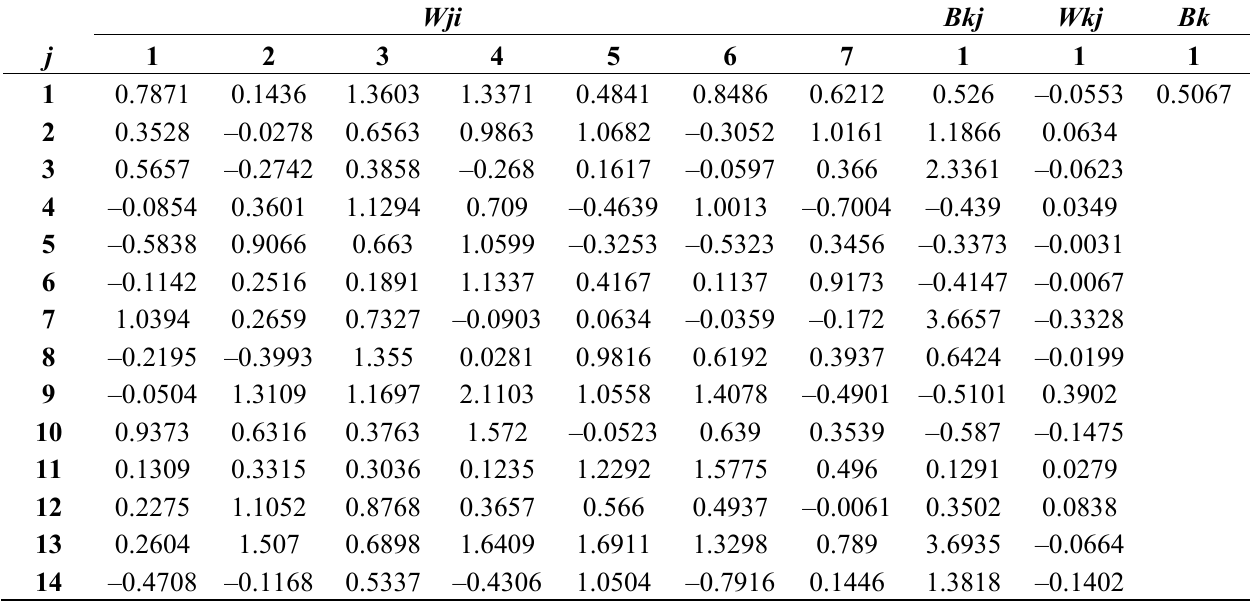
Table 11. The final weights and thresholds as determined by GA and